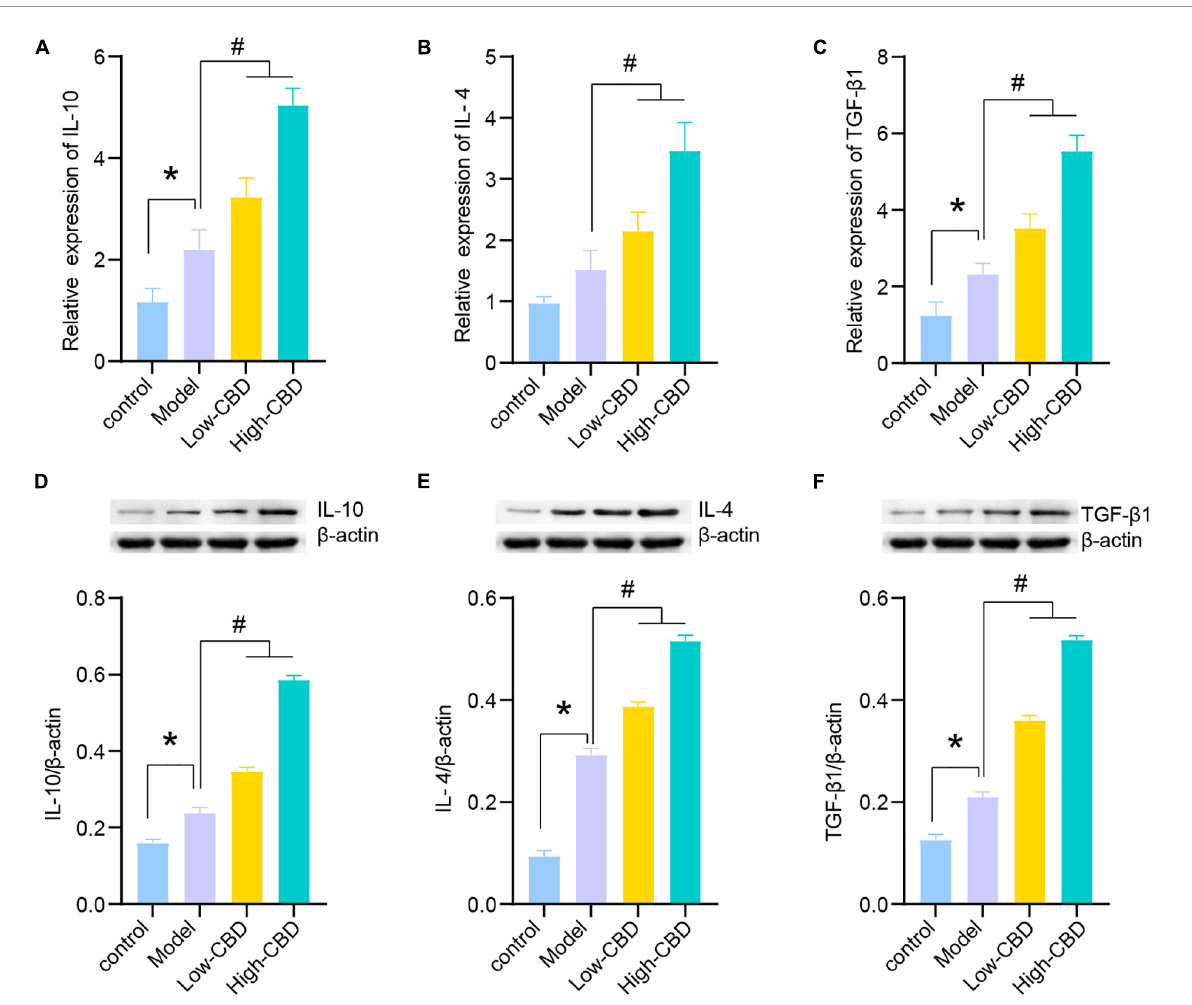
FIGURE4 Effects of cannabidiol (CBD) on the expression of IL-10, IL-4, and TGF- β 1 in the temporal lobe cortex of epileptic rats. (A-C) IL-10, IL-4, and TGF- β 1 were detected by qRT-PCR. (D-F) IL-10, IL-4, and TGF- β 1 were detected by western blotting (WB). *Represents significant comparison with the control group, #represents significant comparison with the Model group, P <